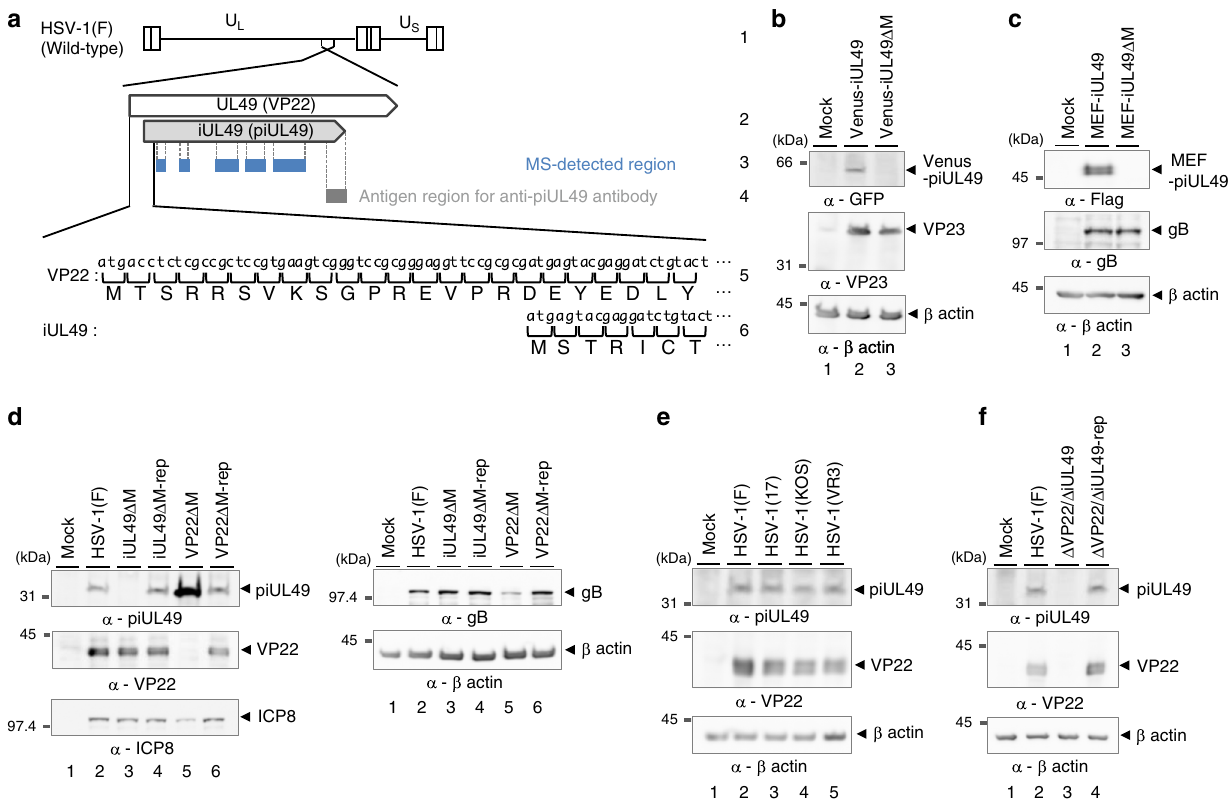
Fig. 2 Expression of piUL49 in HSV-1-infected cells. a Schematic diagram of the genome of wild-type HSV-1 (line 1) and the locations of the UL49 (VP22) and iUL49 (piUL49) CDSs (line 1). The domain(s) of iUL49 detected by MS-analyses (line 3) or used to generate antibodies to piUL49 (line 4). The nucleotide and amino-acid sequences of VP22 (line 5) and piUL49 (line 6) are indicated. b , c Vero cells mock-infected or infected with Venus-iUL49 ( b ), Venus-iUL49 Δ M ( b ), MEF-iUL49 ( c ), or MEF-iUL49 Δ M ( c ) for 12 h at an MOI of 10 were analyzed by immunoblotting with antibodies to GFP ( b ), VP23 ( b ), Flag ( c ), gB ( c ), or β actin ( b , c ). d Vero cells mock-infected or infected with wild-type HSV-1(F), iUL49 Δ M, iUL49 Δ M-rep, VP22 Δ M, or VP22 Δ M-rep for 12 h at an MOI of 10 were analyzed by immunoblotting with antibodies to piUL49, VP22, ICP8, gB, or β actin. e , f Vero cells mock-infected or infected with wild-type HSV-1(F) ( e , f ), HSV-1(17) ( e ), HSV-1(KOS) ( e ) or HSV-1(VR3) ( e ), Δ VP22/ Δ iUL49 ( f ), or Δ VP22/ Δ iUL49-rep ( f ) for 12 h at an MOI of 10 were analyzed by immunoblotting with antibodies to piUL49, VP22, or β actin. Digital images are representative of three independent experiments ( b – f